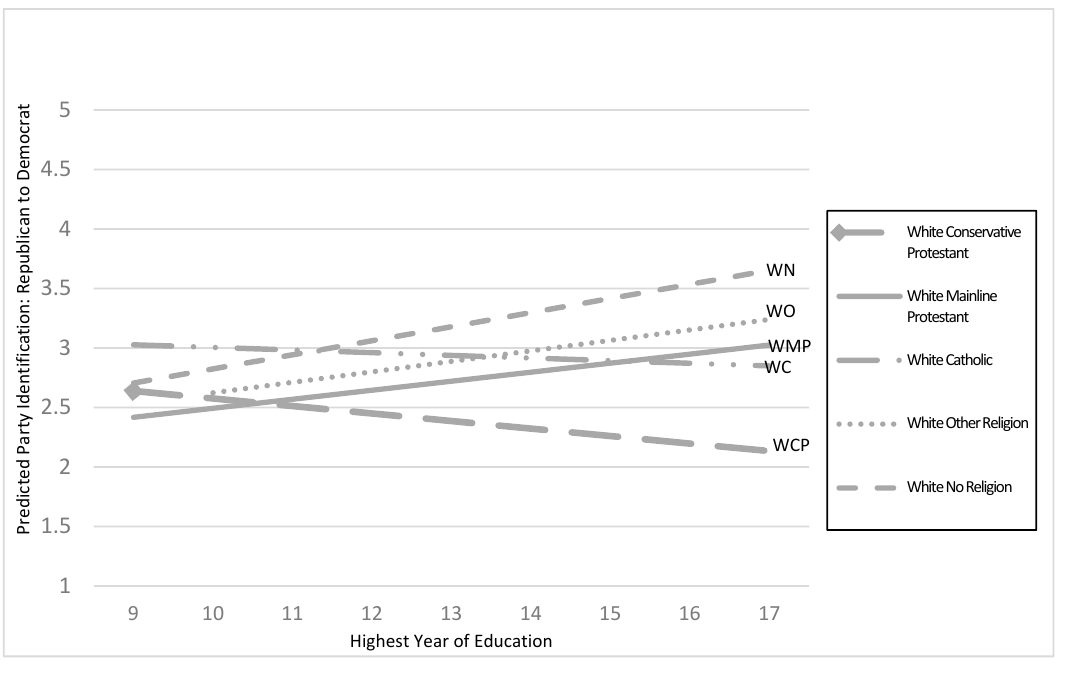
Figure 7. The interaction of religion and education on party identification.